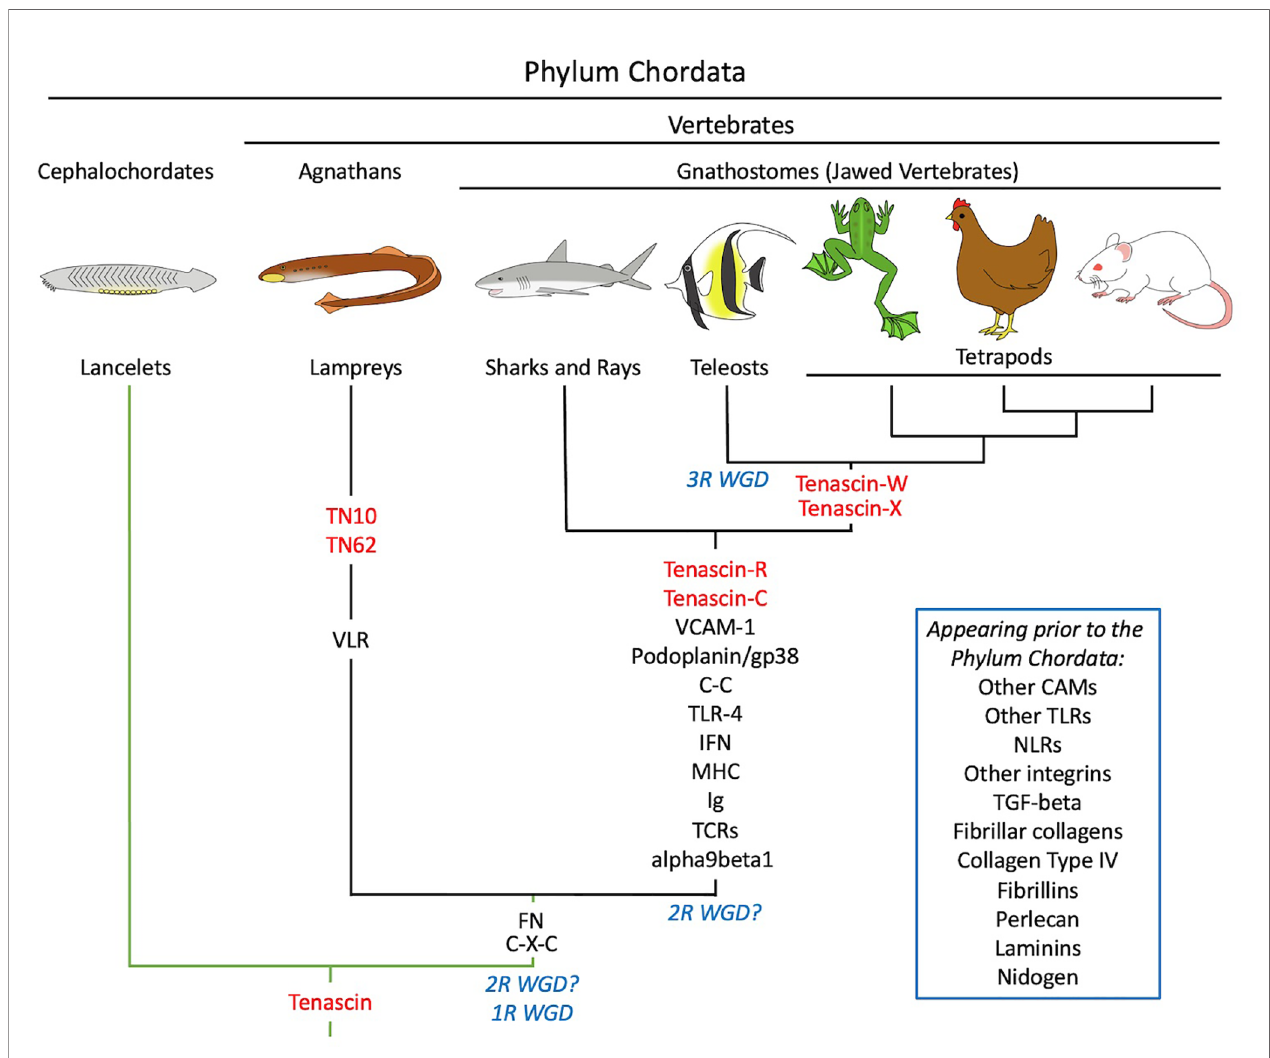
FIGURE 1 | A schematic illustration of the co-evolution of tenascins (in red) and elements of the immune systems of representative chordates. Tenascins fi rst appeared in invertebrate members of the phylum Chordata like the cephalochordates. Branches in green indicate chordates lacking an adaptive immune system, while branches in black indicate chordates with both innate and adaptive immunity. In the vertebrates, the jawless agnathans (e.g., lamprey) evolved adaptive immunity based on variable lymphocyte receptors (VLRs); the fi rst chemokines (C-X-C) and fi bronectin (FN) appeared at this time as well. Tenascin-C fi rst appeared in the jawed vertebrates (gnathostomes), together with immunoglobulin (Ig)-based adaptive immunity, the major histocompatibility complex (MHC), additional chemokines (C-C), interferons (IFN), T-cell receptors (TCR), Toll-like receptor 4 (TLR4) and the integrin a 9 b 1. Podoplanin/gp38 and VCAM-1 appeared at this time as well. Many key elements of reticular fi bers and vertebrate immune systems predate the evolution of chordates and are included in the inset. See text for details. 1R WGD, First round whole genome duplication; 2R WGD (with the question marks showing two proposed periods for this event), Second round whole genome duplication; 3R WGD, third round whole genome duplication; CAMs, cell adhesion molecules; TN10 and TN62, lamprey-speci fi c tenascins; NLRs, nucleotide-binding oligomerization domain-like